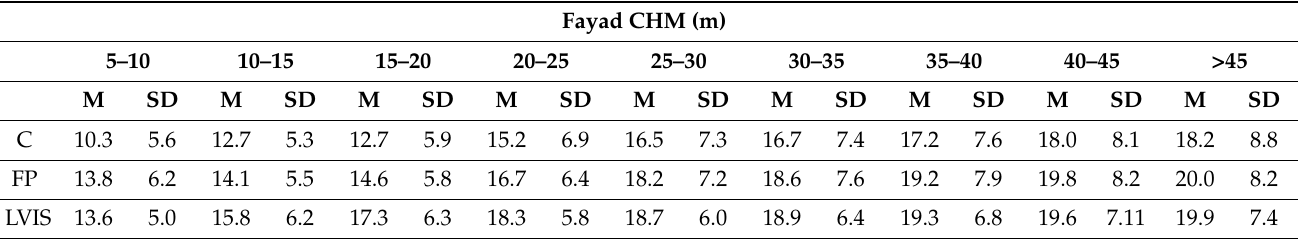
Table A4. Mean (M) and standard deviation (SD) in meters of the elevation difference between EHR and SRTM for shots with a sensitivity ≥ 98%. (C) and (FP) correspond to the ELM values from GEDI’s coverage and full-power lasers, respectively. (LVIS) corresponds to the ELM values from LVIS. Fayad CHM